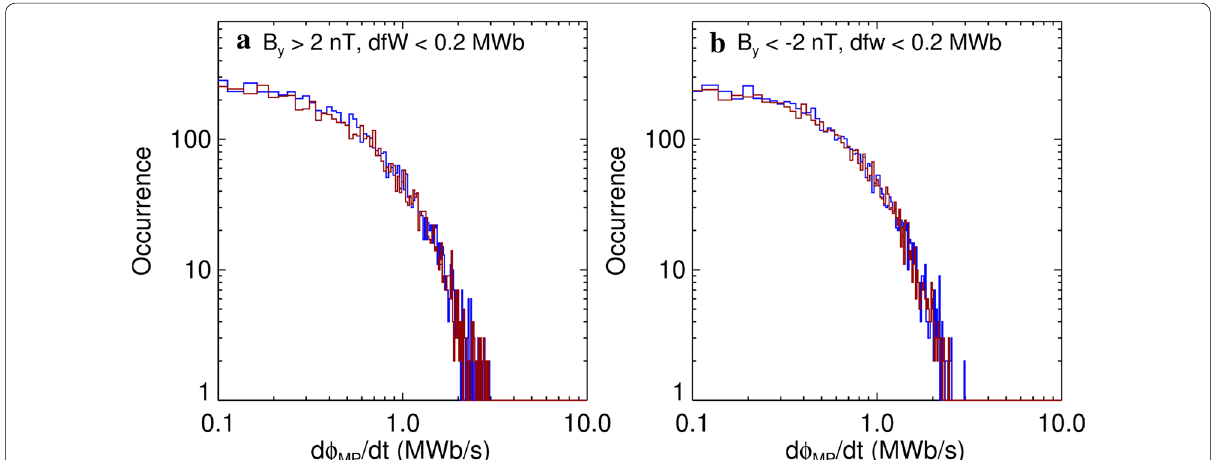
Fig. 2 Histogram of the coupling function, d φ MP / d t , for a IMF B y > 2 nT and b IMF B y < hemispheric events, whereas the red trace is for the Southern hemispheric events. The time-weighted coupling function, d φ W MP / d t , for both cases is limited within 0.2 MWb/s (see text for